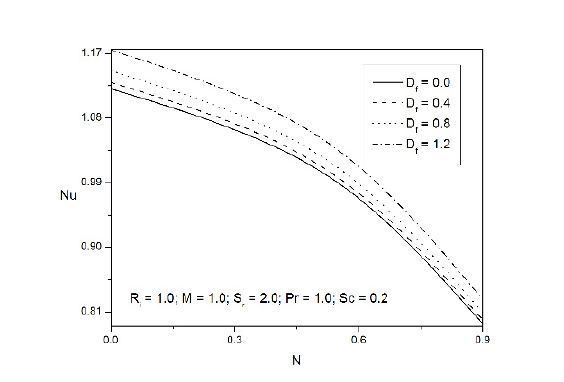
Figure 14. Effect of Soret number S